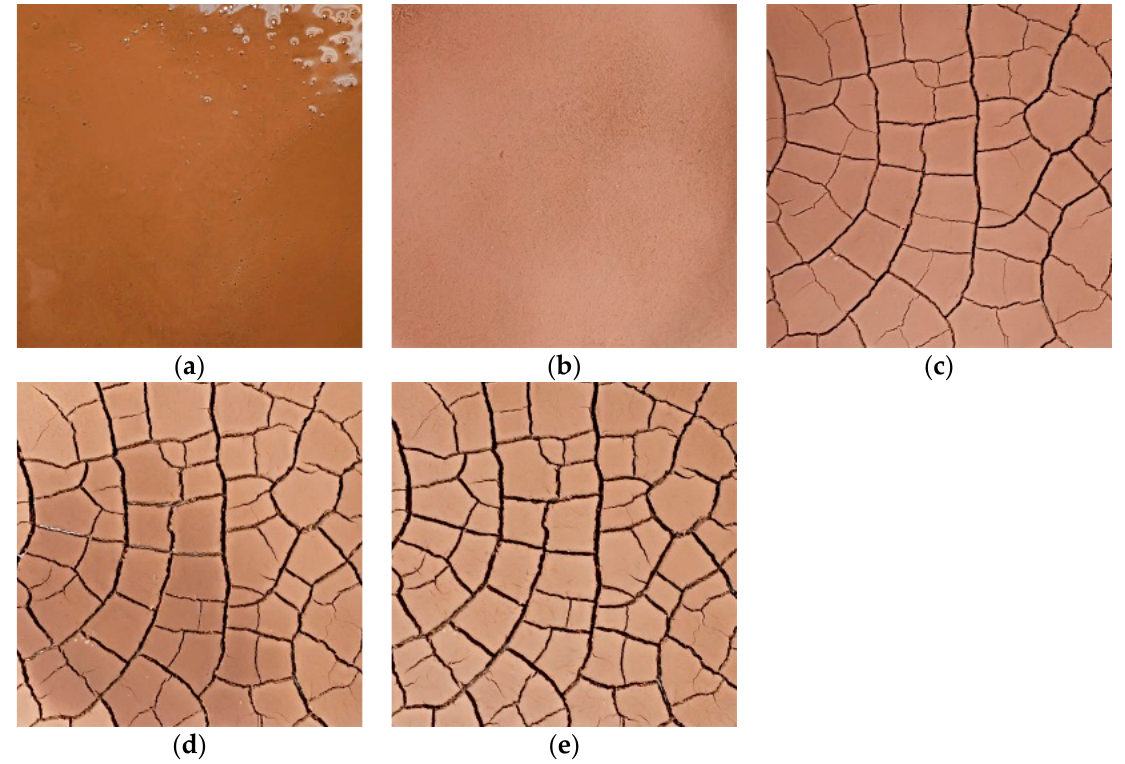
Figure 3. Fracture development morphology of soil sample of group S1 specimens. ( a ) 0 h; ( b ) 1 h; ( c ) 2 h; ( d ) 2.5 h; ( e ) 2.6 h.